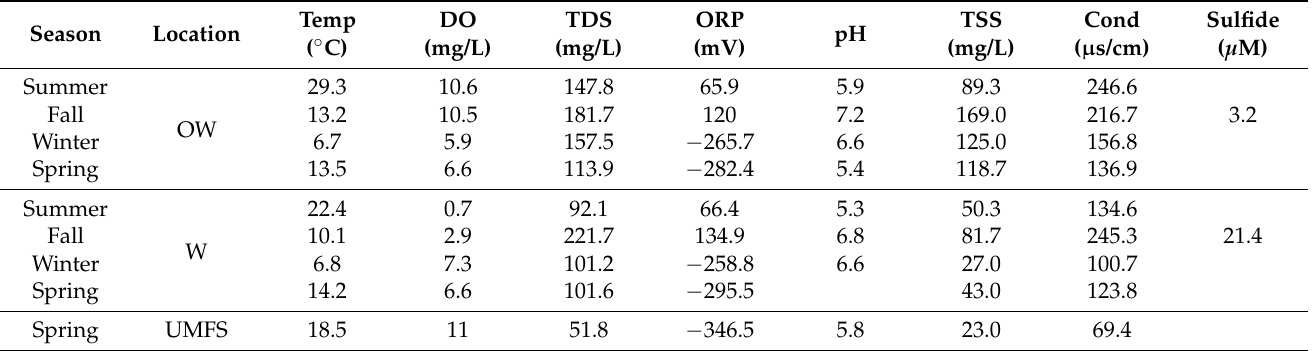
Table 2. Water quality parameters for Sky Lake open water and wetland areas during